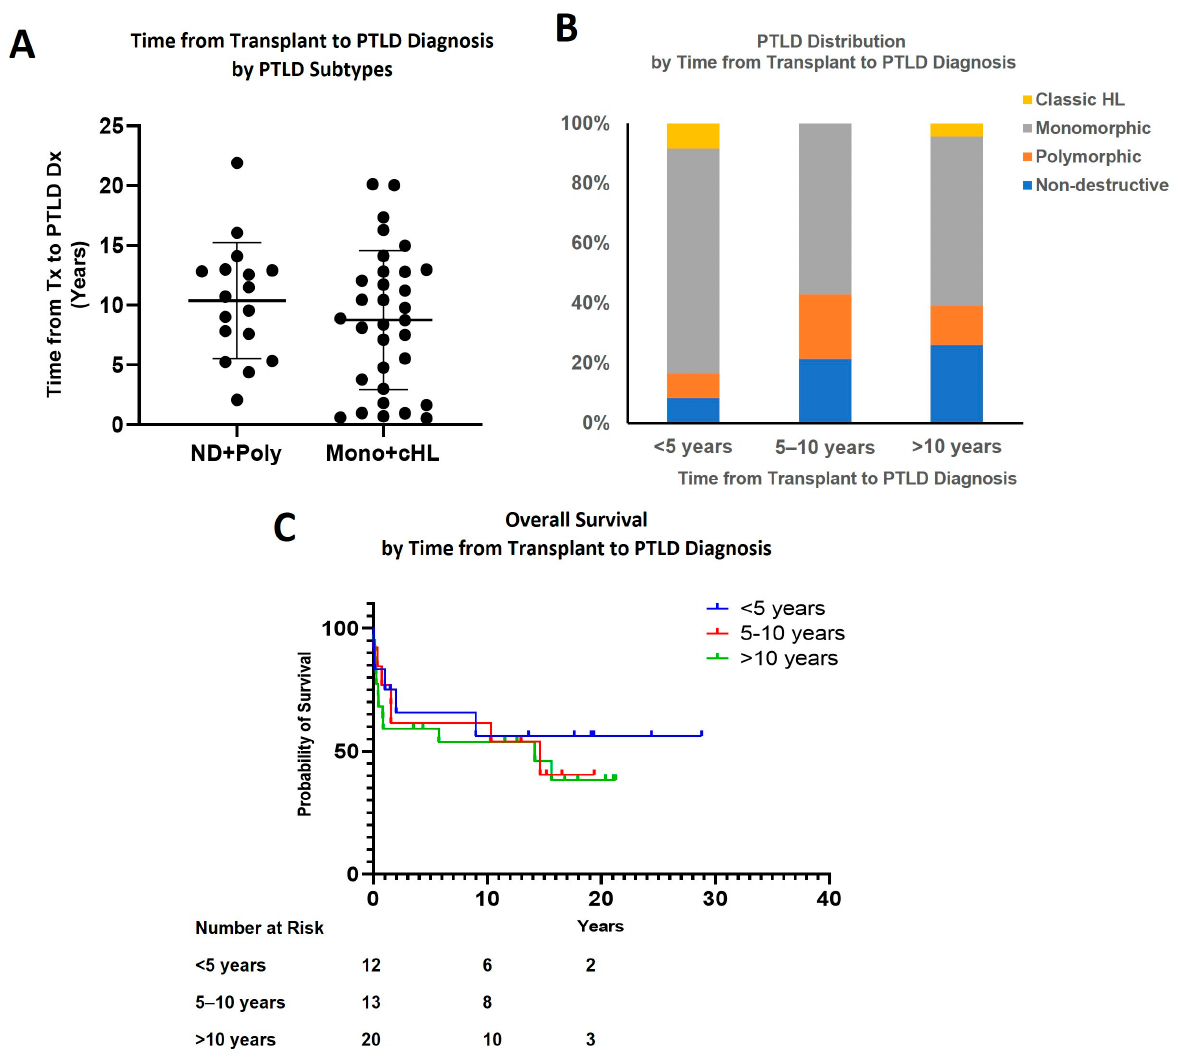
Figure 4. Effect of time interval from transplant to PTLD diagnosis. ( A ) Time from transplant to PTLD diagnosis by PTLD subtype; ( B ) PTLD distribution by time from transplant to PTLD diagnosis; ( C ) Overall survival by time from transplant to PTLD diagnosis.